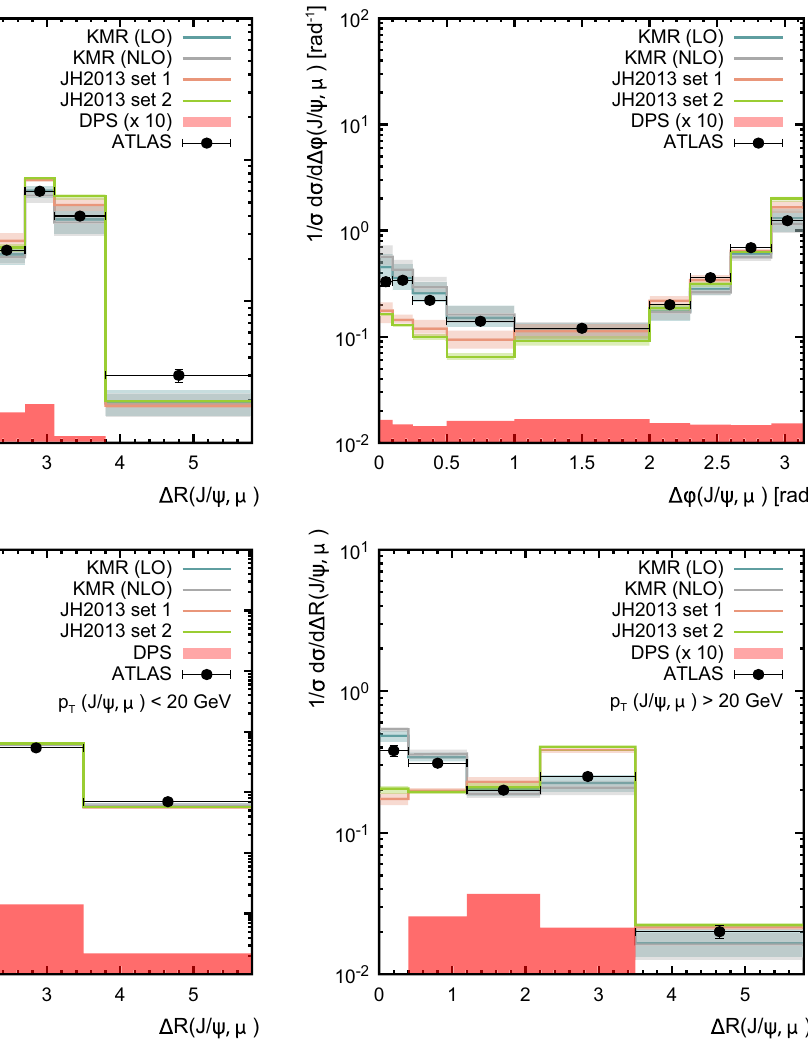
Fig. 1 The normalized differential cross sections of associated non- racy) and CCFM-evolved TMD gluon densities. The shaded bands rep- √ s = 8 TeV as a function of prompt J /ψ + μ production at resent the scale uncertainties of the calculations, as it is described in the (cid:3) R ( J /ψ,μ) , (cid:3)φ( J /ψ,μ) , low and high- p (cid:3) R ( J /ψ,μ) . Predic- text. The DPS contributions are estimated using JH’2013set2 gluon T tions are made using the KMR (calculated with the LO and NLO accu- density. The experimental data are from ATLAS